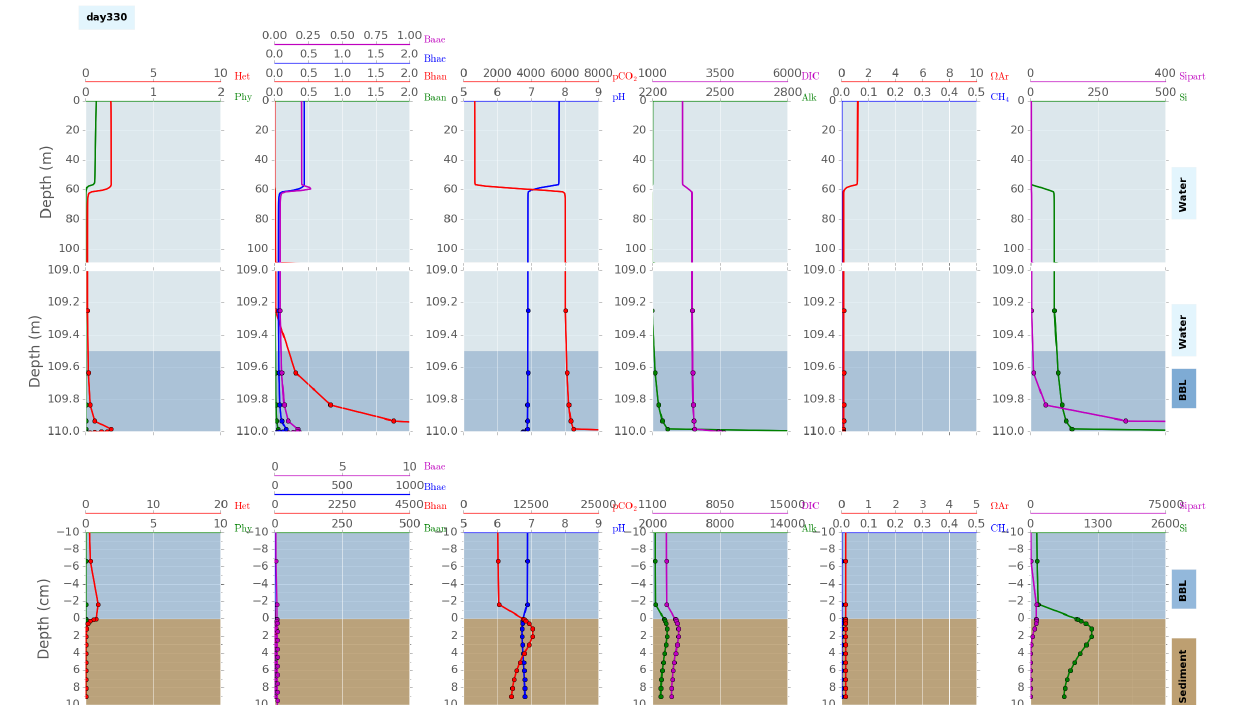
Figure 4. Vertical distributions of the modeled chemical parameters (µM), biological parameters (µM N), temperature ( ◦ C), salinity (PSU), and vertical diffusivity (10 − 3 m 2 s − 1 ) during the period of bottom anoxia, showing the water column (light blue), the benthic boundary layer (dark blue), and the sediments (light brown).